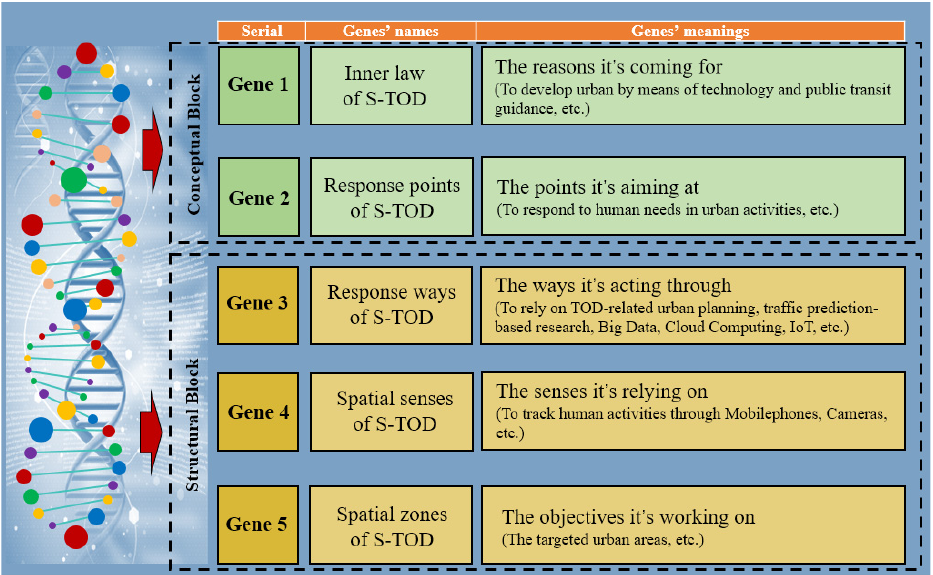
Figure 11. The DNA map of S-TOD.